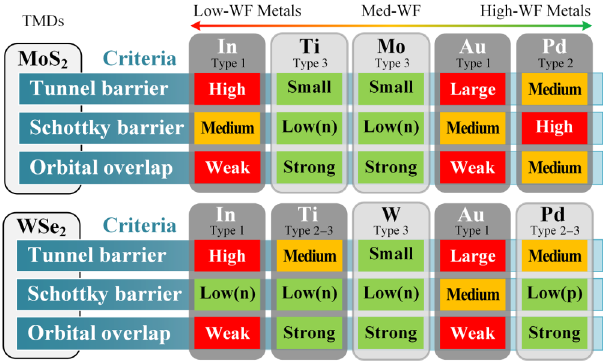
FIG. 17. Summary of metal-mTMD top-contact electron in- jection efficiency, in terms of orbital overlap, Schottky barrier, and tunnel barrier.